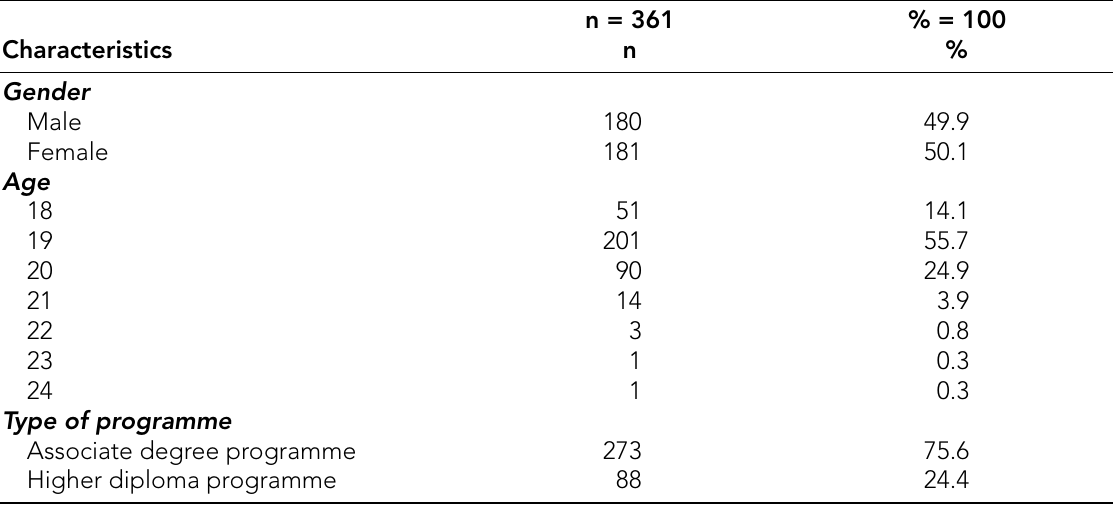
Table 2. Characteristics of the sample (Source: Authors, 2022)